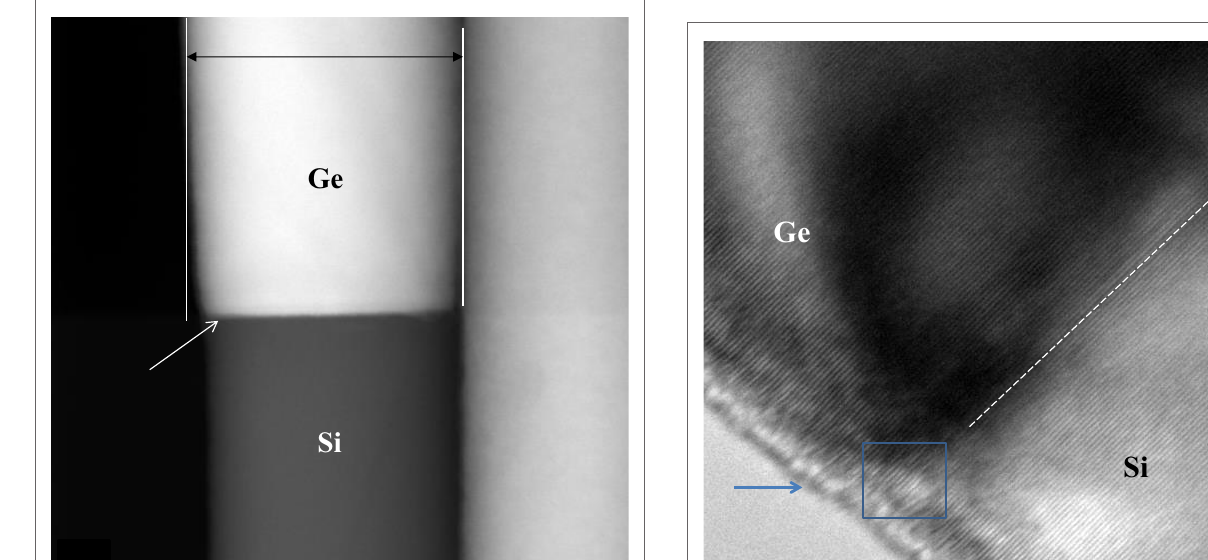
FiGURe 4 | High-resolution TeM image of the Si/Ge Nw HJ interface close to the Nw center with clearly visible (111) lattice fringes (wang et al., 2015) .